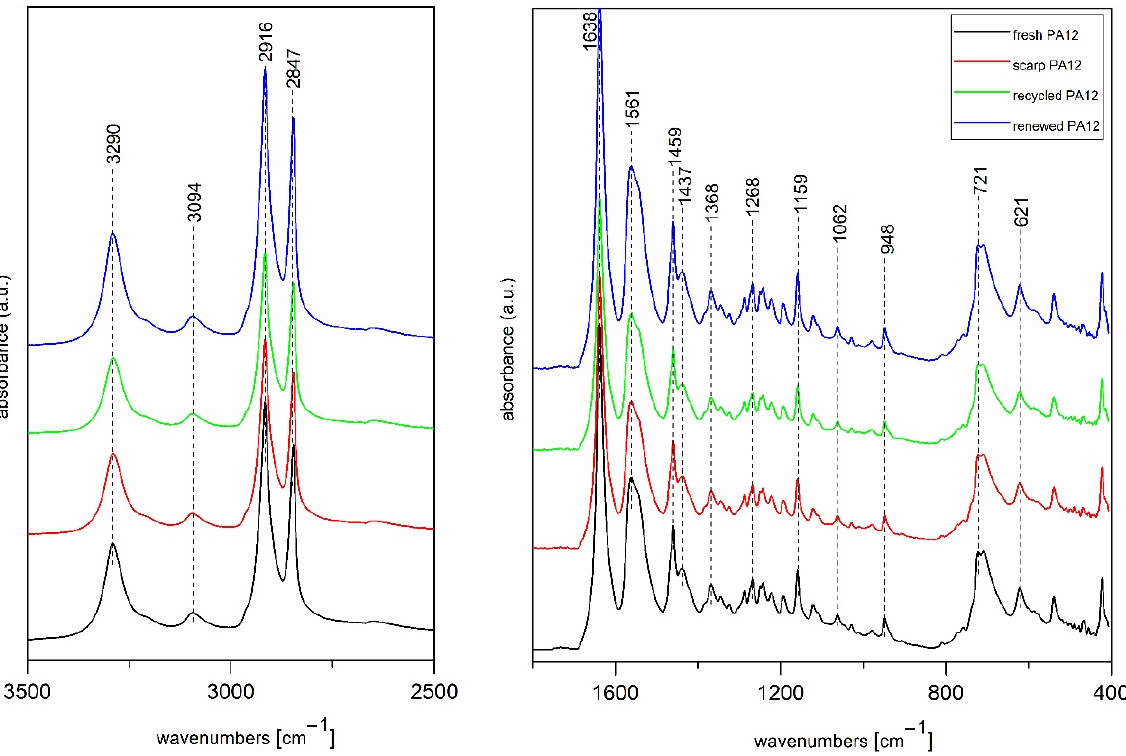
Figure 7. Fourier transform infrared (FTIR) spectra of PA 12 samples: fresh PA 12, scrap PA 12, recycled PA 12, and renewed PA 12. Table 4. Characteristic infrared bands and their assignments of PA12 samples.